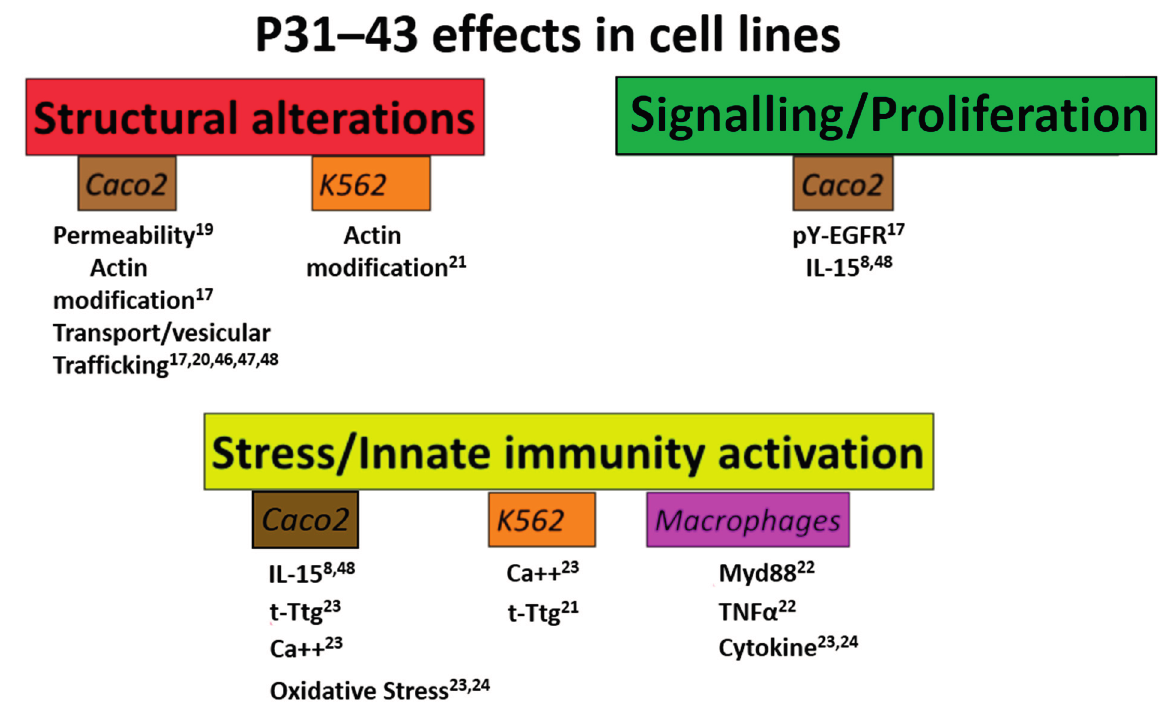
Figure 1. Peptide 31–43 (P31–43) has several effects on cell lines. Schematic representation of the effects of gliadin peptide P31–43 on several cell lines (Caco2, K562, Macrophages). The main effects were grouped in three sets: structural alterations (permeability, actin modifications and alterations in vesicular trafficking), signaling/proliferation (epithelial growth factor/epithelial growth factor receptor- interleukin-15/interleukin-15 receptor- α (EGF/EGFR-IL-15/IL-15R- α ) activation, pY-extracellular signal-regulated kinase (pY-ERK)) and stress/innate immunity activation. In all cases there was a quantitative increase in the markers cited, although in the case of actin, the alterations were qualitative. Numbers indicate the bibliographic